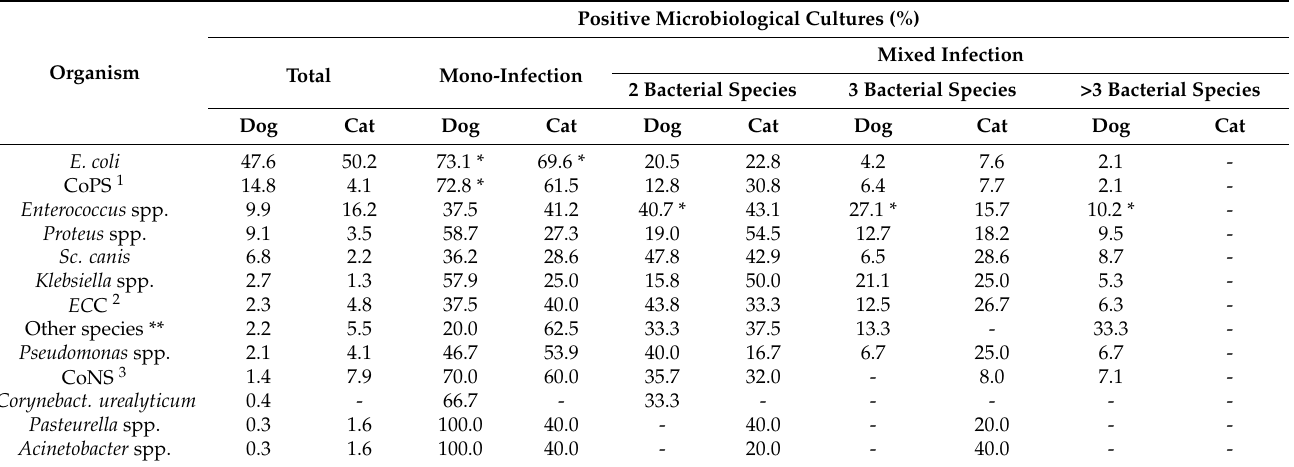
Table 2. Prevalence of bacterial species (697/313 isolates from dogs/cats) isolated from urinary tract samples, single vs. mixed infection with two, three, or more bacterial